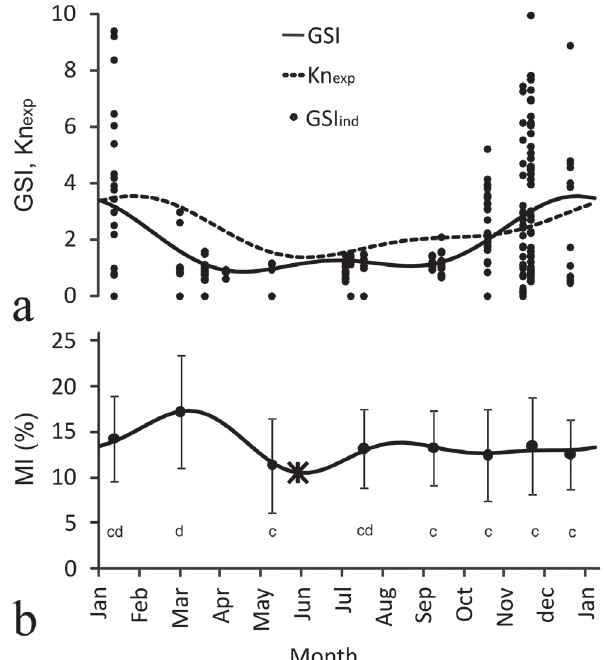
Fig. 5. Trahira annual variation of observed individual Gonadosomatic index (GSI) and its respective fitted model, and expanded condition index (Knexp) curve ( a ). Mean relative marginal-increment scale index (MI%) and its respective standard deviations at each sampling date with the corresponding fitted model. Asterisk in MI (%) curve indicates the mean date of ring formation. Different letters below the MI% mean values indicate significant differences (p<0.05) ( b